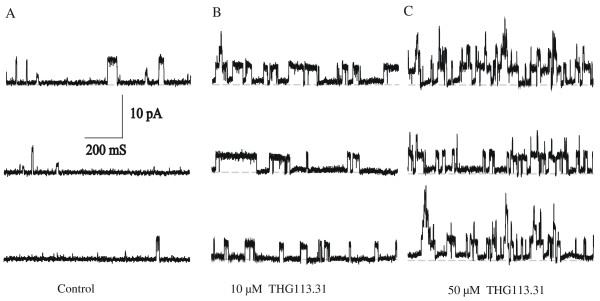
THG113.31 enhances BKCa channel activity in human myometrial smooth muscle cells. A, B & C Representative continuous recordings were recorded from the same cell attached patch (+40 mV) before (control) and 15 min after exposure to 10 & 50 μM THG113.31, respectively. Channel openings are upward deflections from the baseline (closed state) (dashed line).